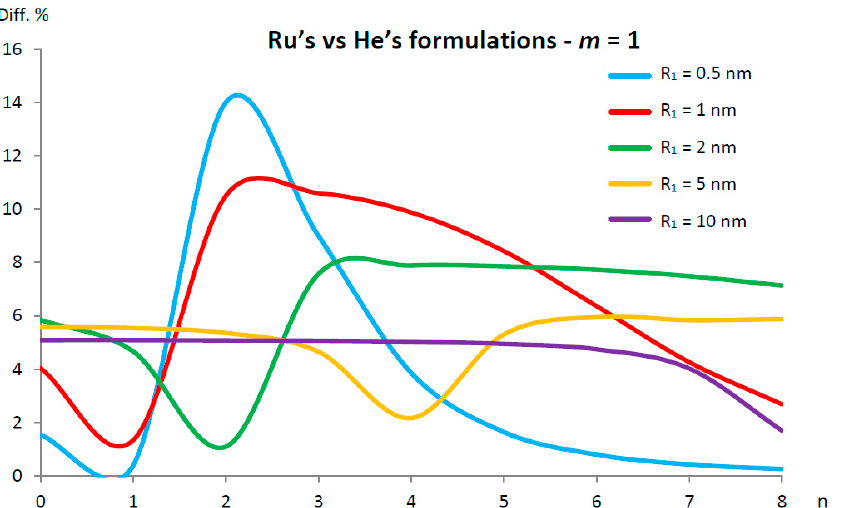
Figure 9. Percentage differences between the highest radial natural frequencies obtained via Ru’s (38) and He’s (39) formulations (He as reference). Donnell shell theory. Anisotropic elastic model. Simply supported DWCNT of Table 1 with m = 1 longitudinal half-wave and aspect ratio L / R 2 = 10. Inner radius R 1 . Number of circumferential waves n.